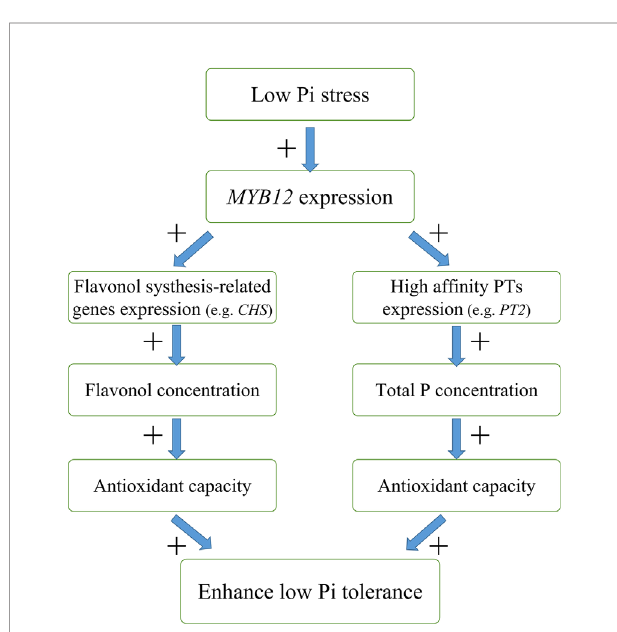
FIGURE 9 | Possible model for the mechanism of interaction between NtMYB12 , fl avonol synthesis, and total P concentration under low Pi stress conditions in tobacco. The model is based on the results presented here. + indicates positive